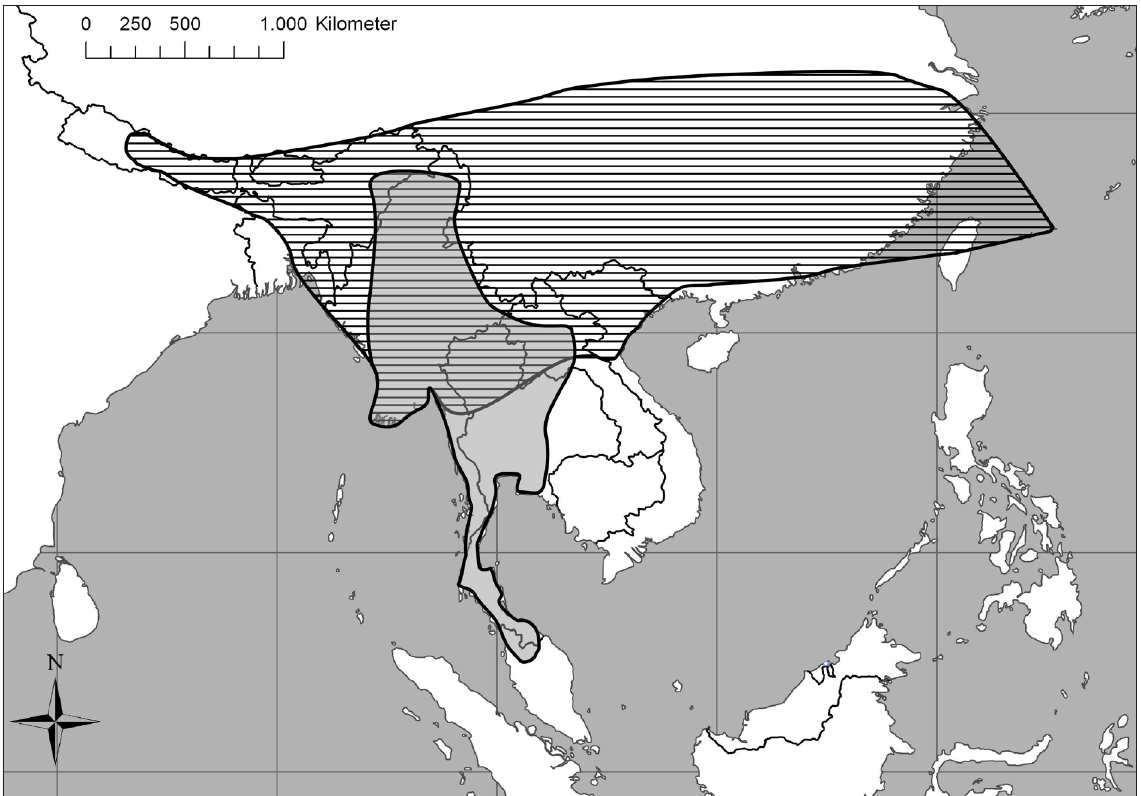
Fig. 3. Distribution of the extant Sinicolinae subfam. nov. (ruled area) and Plectopylinae Möllendorff, 1898 (grey shaded area). Mainly after Páll-Gergely & Hunyadi (2013) and Páll-Gergely et al. (2015b, 2015c,